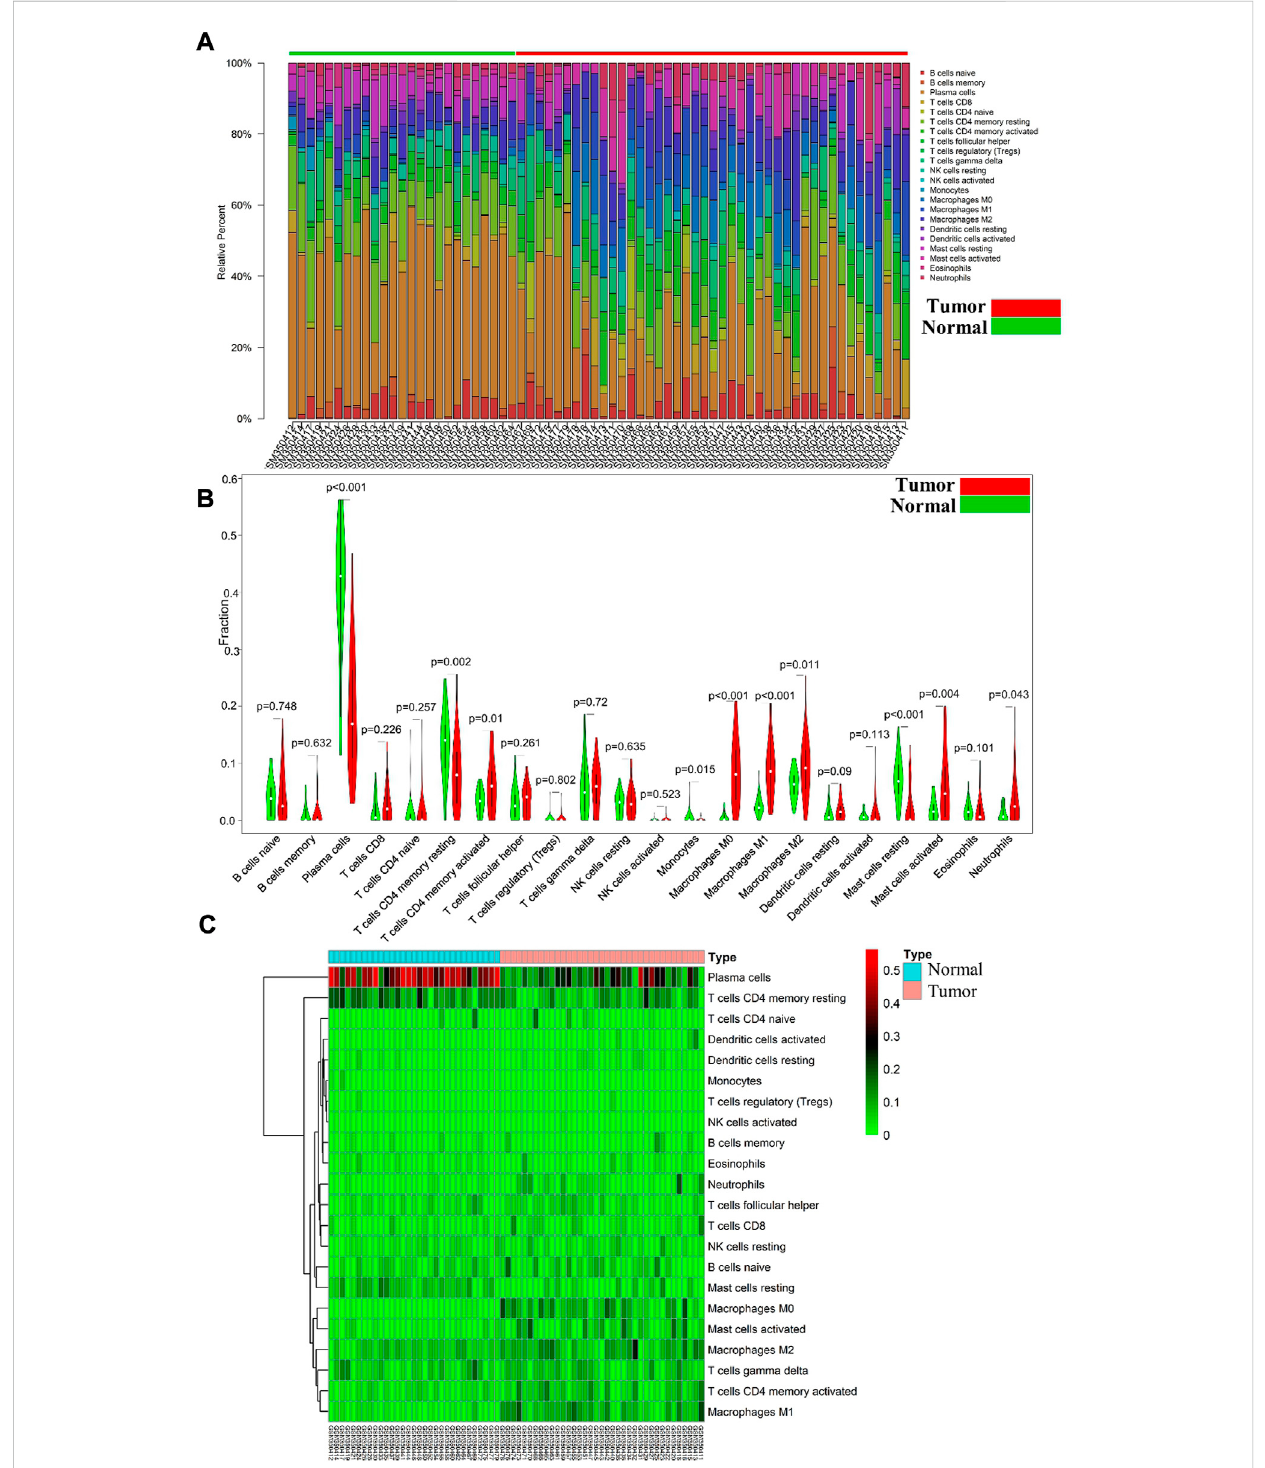
FIGURE 1 (A) Each bar represents a sample, and each color represents a type of immune cell. Area of the color represents the percentage of immune cell in fi ltration responsible for totalimmunecell in fi ltration; (B) . Red and green violin columns represent patients with tumor and normal tissues, respectively. The vertical axis represents the ratio of immune cell in fi ltration responsible for total immune cell in fi ltration. p -value, obtained using the Wilcoxon test, represents the difference between the immune cell in fi ltration level in patients with VSR and VAF; (C) . Each column represents a sample, and each row represents atypeofimmunecell. Color transition from green to redrepresentsan increase inimmunecell in fi ltrationlevel.Contrastgroup= normal tissue; trial group = tumor